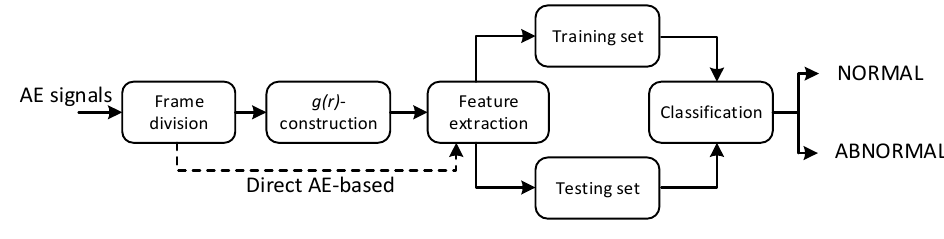
Figure 6. Leak detection procedures.